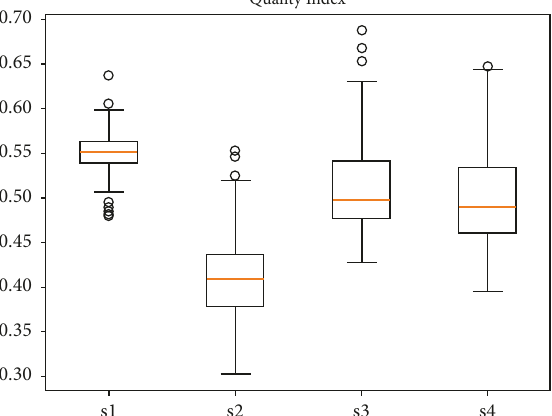
Figure 6: Comparison of strategies ( 𝑡ℎ 𝑠𝑡𝑟𝑜𝑛𝑔−𝑡𝑖𝑒 = 5 ): average standard deviation of resources utilization across 100 simulation